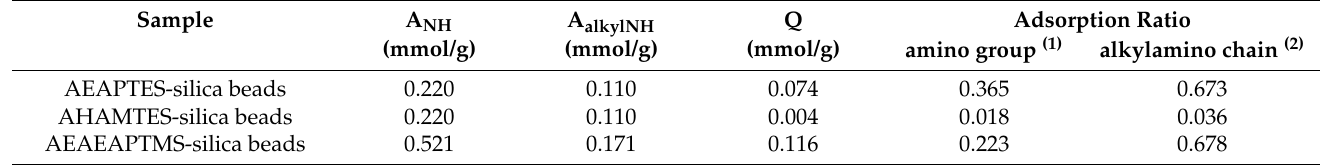
Table 1. The Cr(VI) ion adsorption on silica beads functionalized with different aminosilane